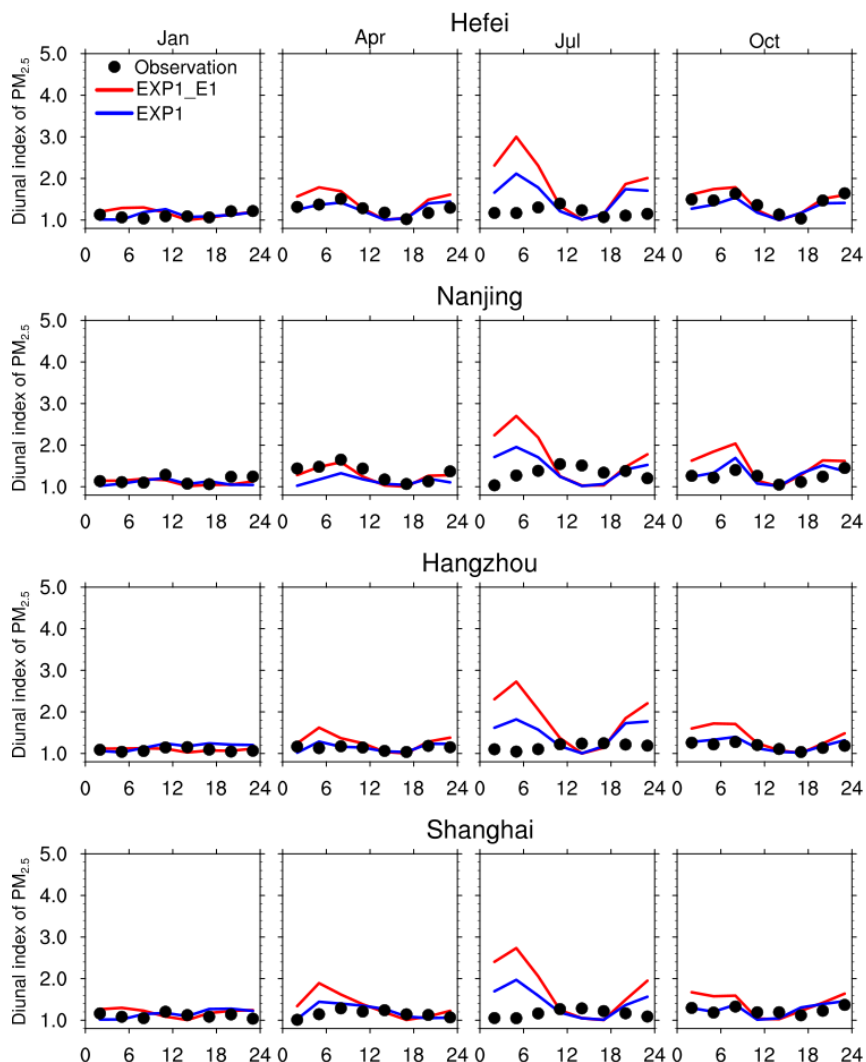
Figure 14. Diurnal index of surface PM 2 . 5 concentrations within 24h averaged over four cities (Hefei, Nanjing, Hangzhou, Shanghai) for January, April, July, and October of 2018 from experiments EXP1_E1 and EXP1 and